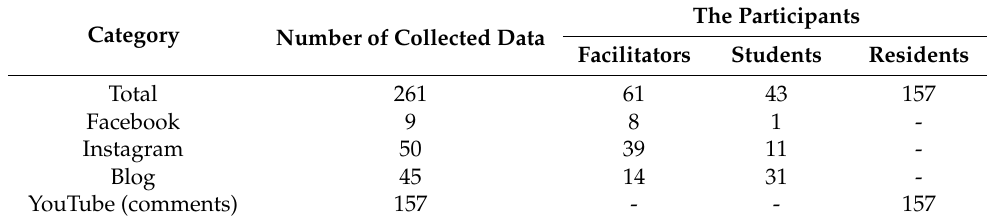
Table 1. Data collection